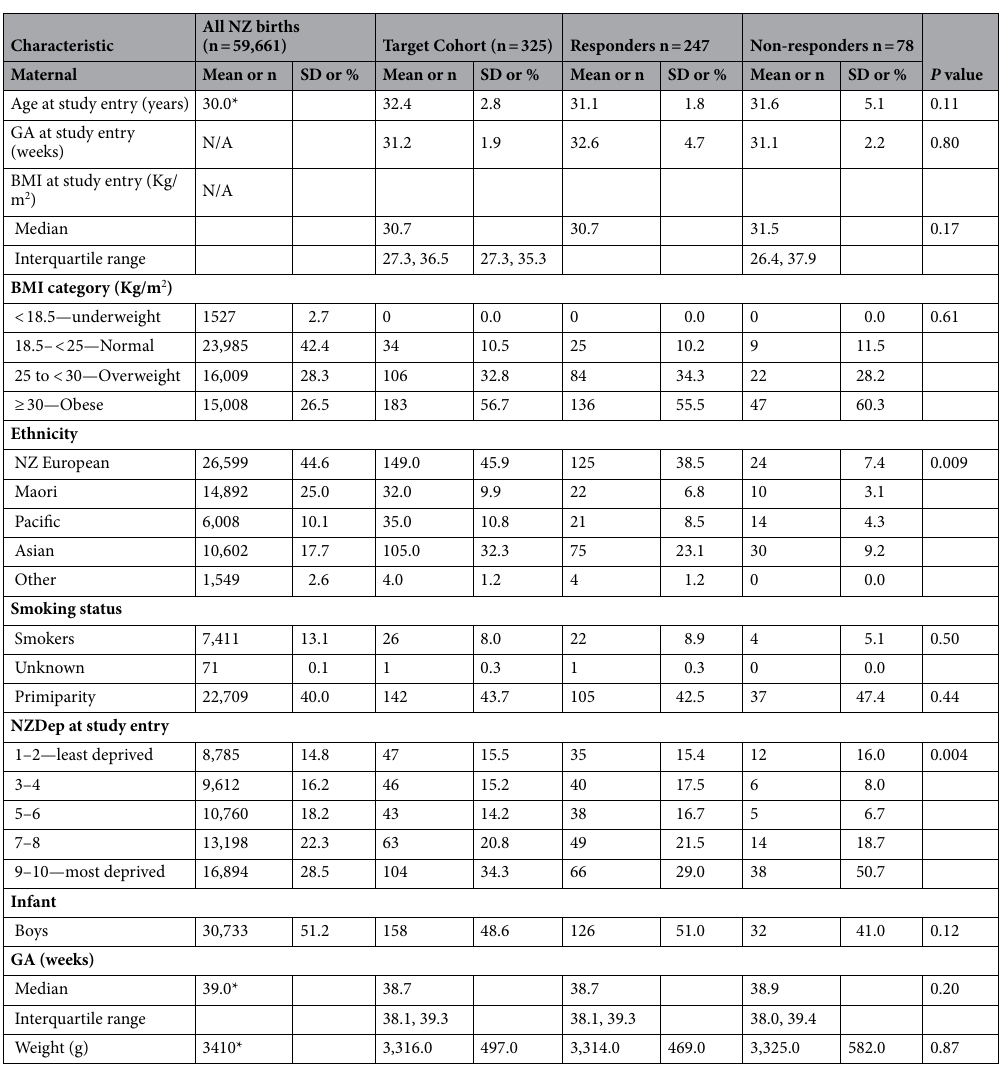
Table 1. Characteristics of women and infants in the study cohort, those who did and did not respond to the infant feeding questionnaires, and all New Zealand births in 2017. NZ New Zealand, n total number of participants, SD standard deviation, N/A not applicable, GA gestational age, BMI body mass index, NZDep New Zealand Deprivation index. *Median/mean values with no measure of spread data available; Data for all New Zealand births from the Ministry of Health, New Zealand; p values compare responders and non-